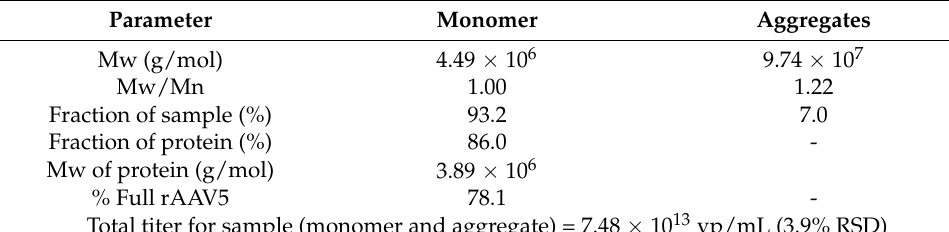
Figure 2. Triple detection chromatogram of rAAV5 (Full). Red = RI; purple = UV 260 nm; green = RALS. Table 3. Quantitative parameters for rAAV5 (Full).